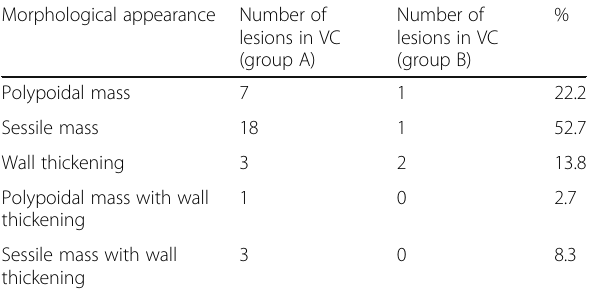
Table 3 The number of lesions according to their morphological description